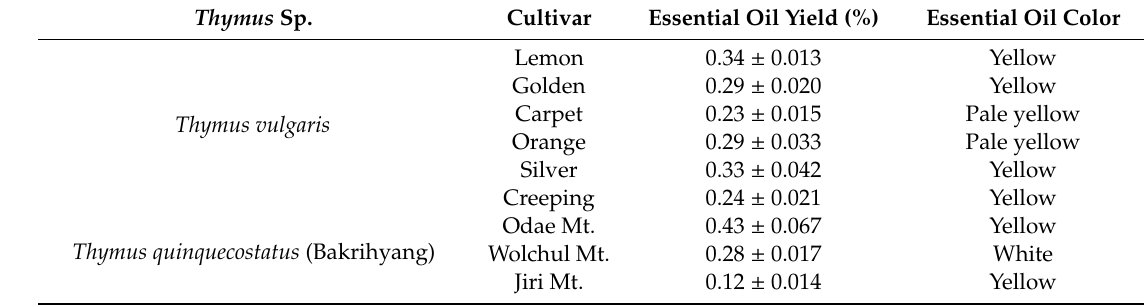
Table 3. The yield and color of the essential oils isolated from the six commercial Thymus vulgaris cultivars and the three Korean native Thymus quinquecostatus cultivars.